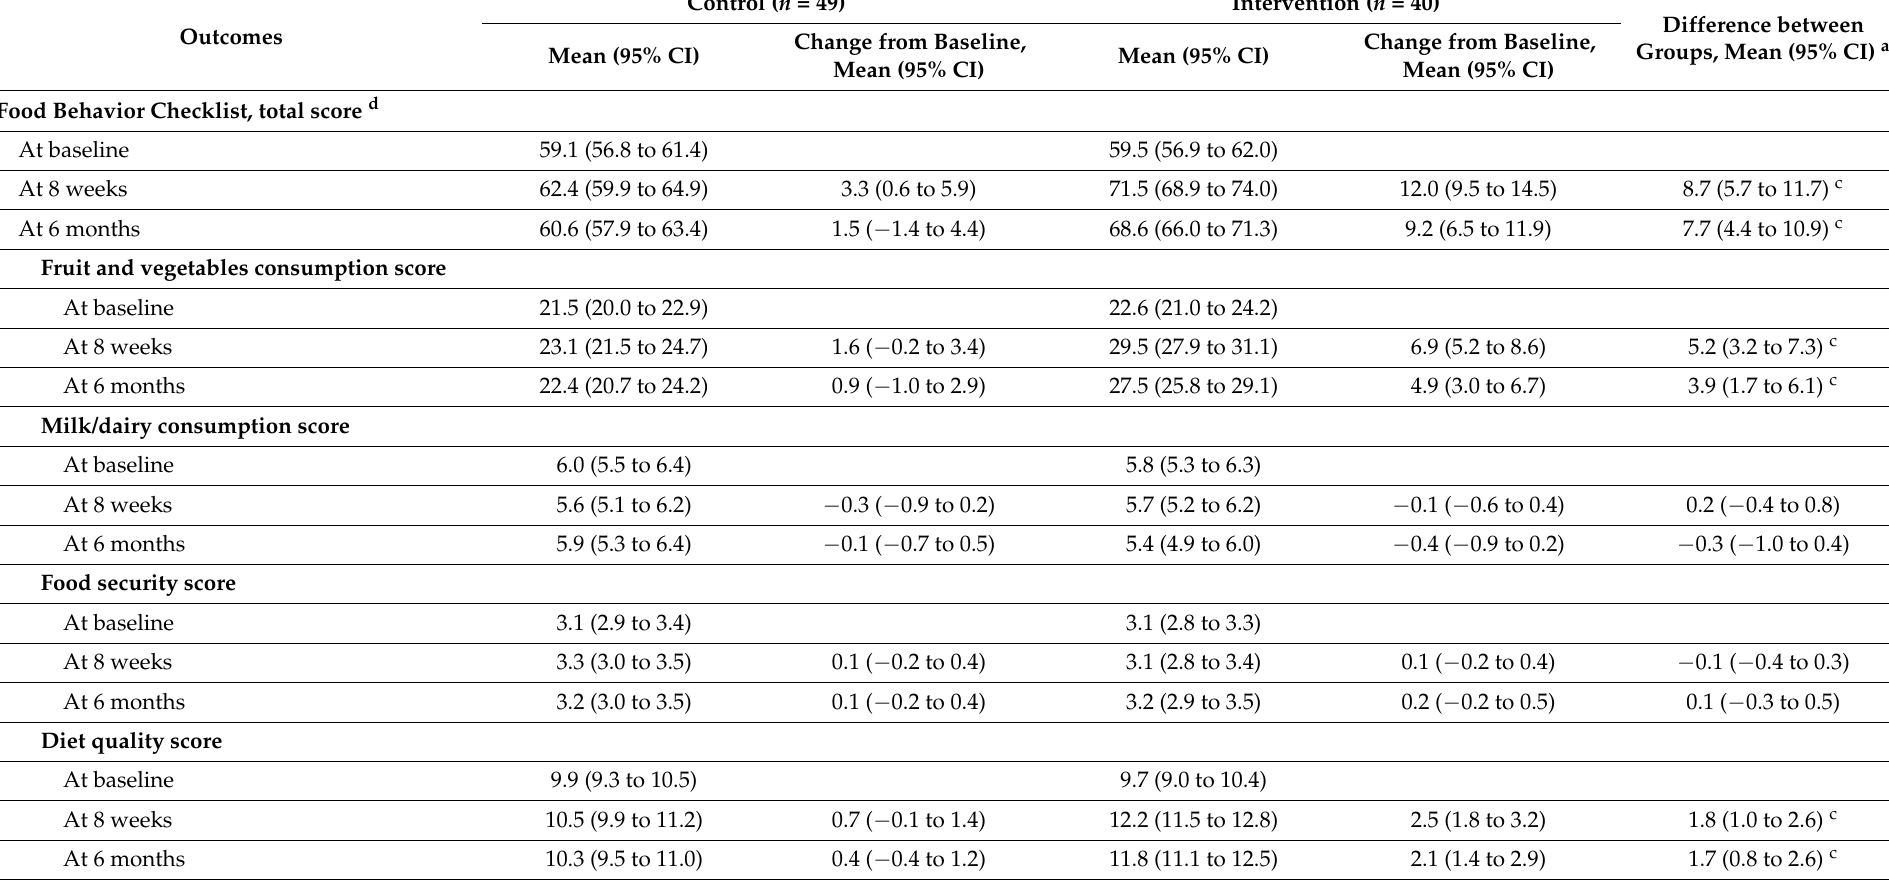
Table 2. Dietary behavior